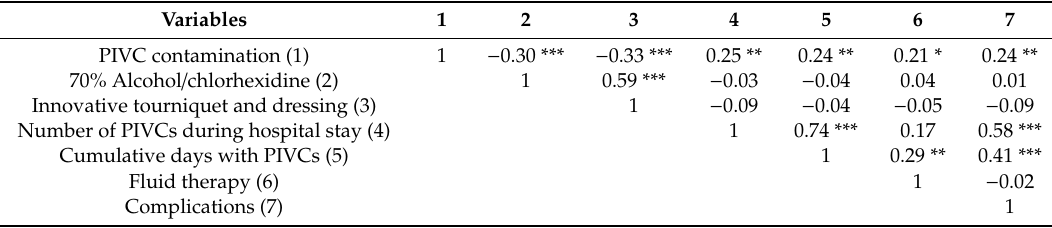
Table 5. Correlation matrix between PIVC contamination and the statistically significant variables for p < 0.100 in the analysis (n =